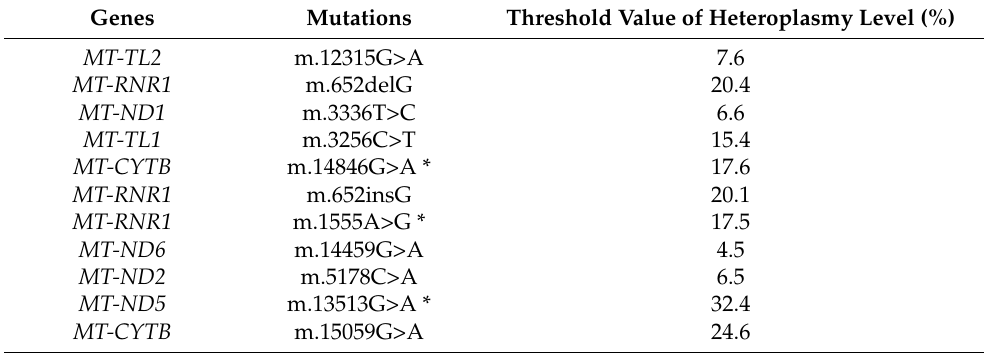
Table 2. Value of heteroplasmy level of mtDNA mutations in atherosclerotic plaques [18,235–239]. Genes